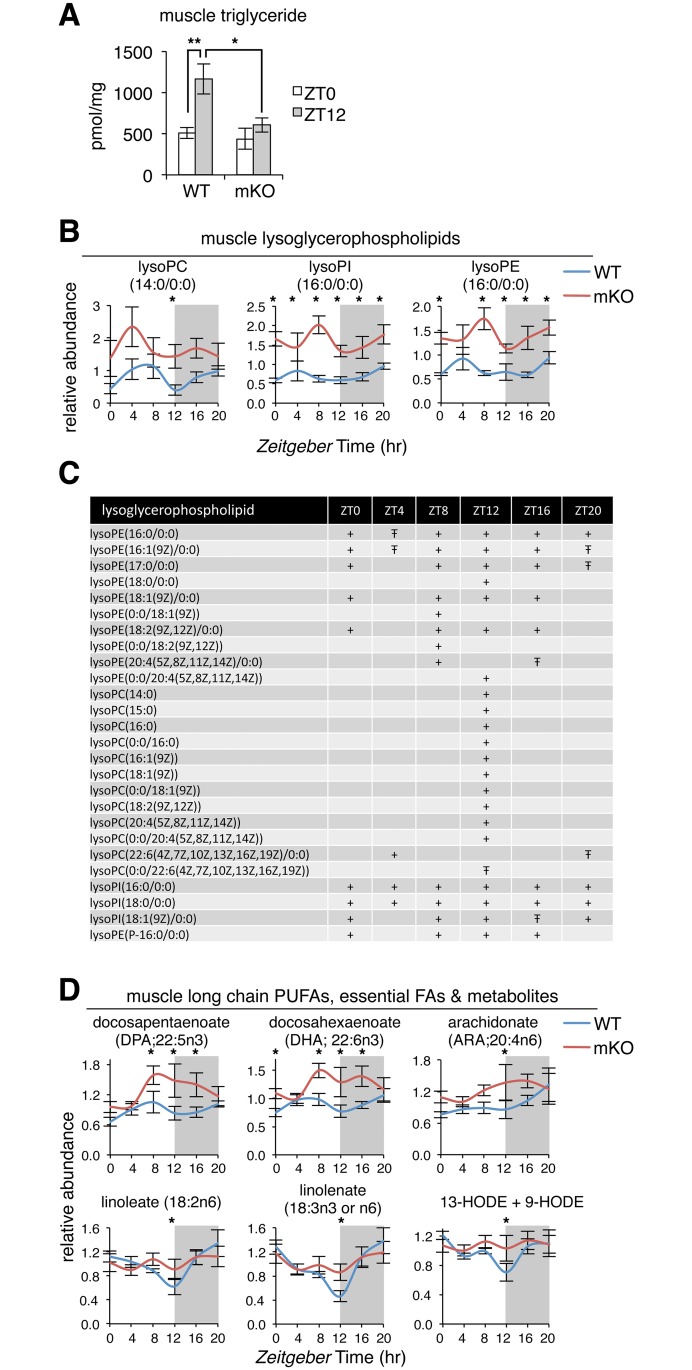
Impaired storage of neutral lipids and accumulation of bioactive lipids in mKO muscles.(A) Muscle triglyceride extracted from gastrocnemius muscles, quantified by HPLC, and normalized to cell protein (mean ± SEM; n = 5 × group × timepoint; **p < 0.01, *p < 0.05, Student’s t test). (B) Diurnal variations of selected lysoglycerophospholipids in WT and mKO TA muscles (mean ± SEM; n = 5 × group × timepoint; *p < 0.05, repeated measures ANOVA). (C) Temporal distribution of significantly increased lysoglycerophospholipids comparing WT and mKO TA (+p < 0.05, Ŧp < 0.1, repeated measures ANOVA). (D) Diurnal variations of selected long-chain PUFAs, essential FAs, and related metabolites in WT and mKO TA muscles (mean ± SEM; n = 5 × group × timepoint; *p < 0.05, repeated measures ANOVA). Underlying data can be found in supporting files S1 Data and S3 Table. FA, fatty acid; HPLC, high-performance liquid chromatography; HODE, hydroxyoctadecadienoate; lysoPC, lysoglycerophosphocholine; lysoPE, lysoglycerophosphoethanolamine; lysoPI, lysoglycerophosphoinositol; mKO, myocyte-specific loss of BMAL1; PUFA, polyunsaturated fatty acid; TA, tibialis anterior; WT, wild type; ZT, Zeitgeber time.